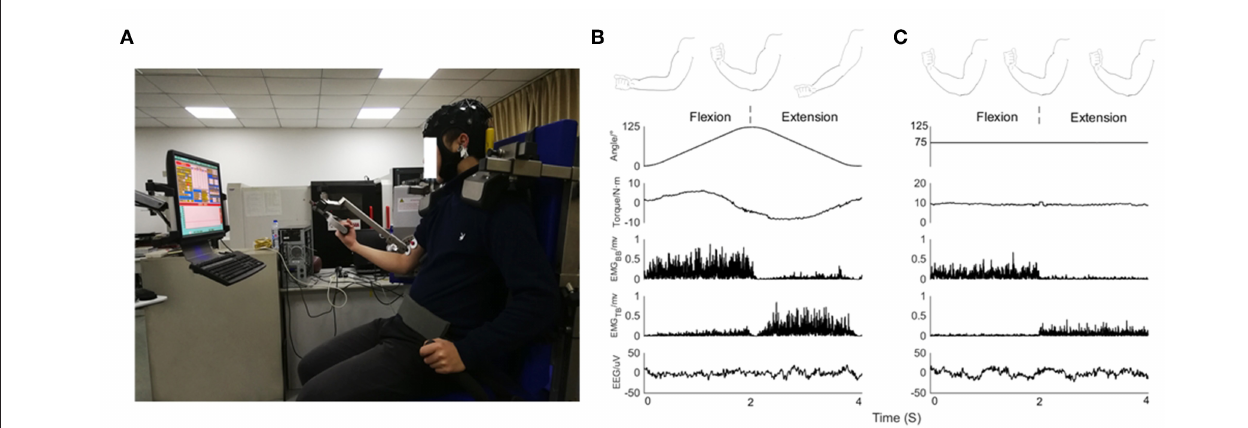
FIGURE 1 | (A) Experimental posture of subject on device, EEG signals from 32 scalp positions recorded together with EMG signals. Feedback about the output torque via blue curve and numbers displayed on a monitor in front of the subject. (B) From top to bottom, kinematic sketch of upper limb during an elbow joint flexion and extension cycle, rotation angle of elbow joint, output torque, rectified EMG signals of BB muscle and TB muscle and EEG signals recorded in a subject during isokinetic movement condition performed at 60 ◦ /s. (C) From top to bottom, kinematic sketch of upper limb during flexion and extension of fixed elbow angle, rotation angle of elbow joint, output torque, rectified EMG signals of BB muscle and TB muscle and EEG signals recorded in a subject during isometric exercise condition performed at 75